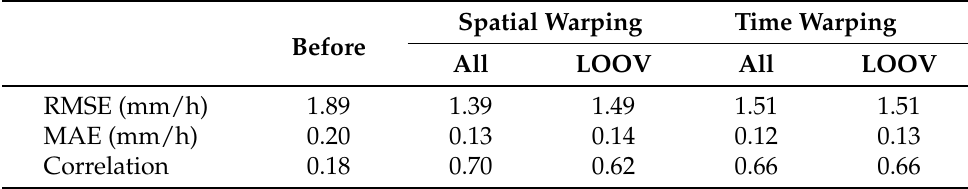
Table 4. Statistics before and after warping compared to the station measurements. The results are shown for the two experiments (“LOOV” and “All”) and the two warping methods. The statistics are computed over all stations and all time